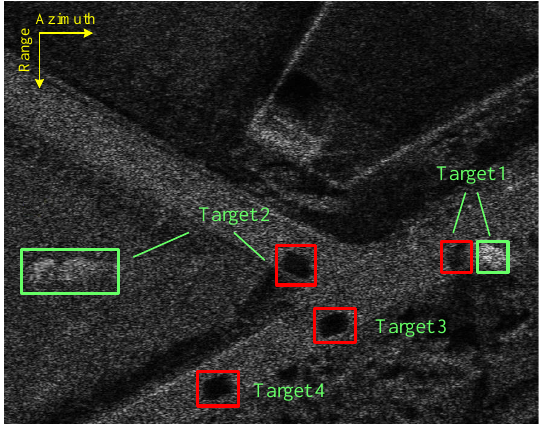
Figure 7. Simulation results of moving targets.